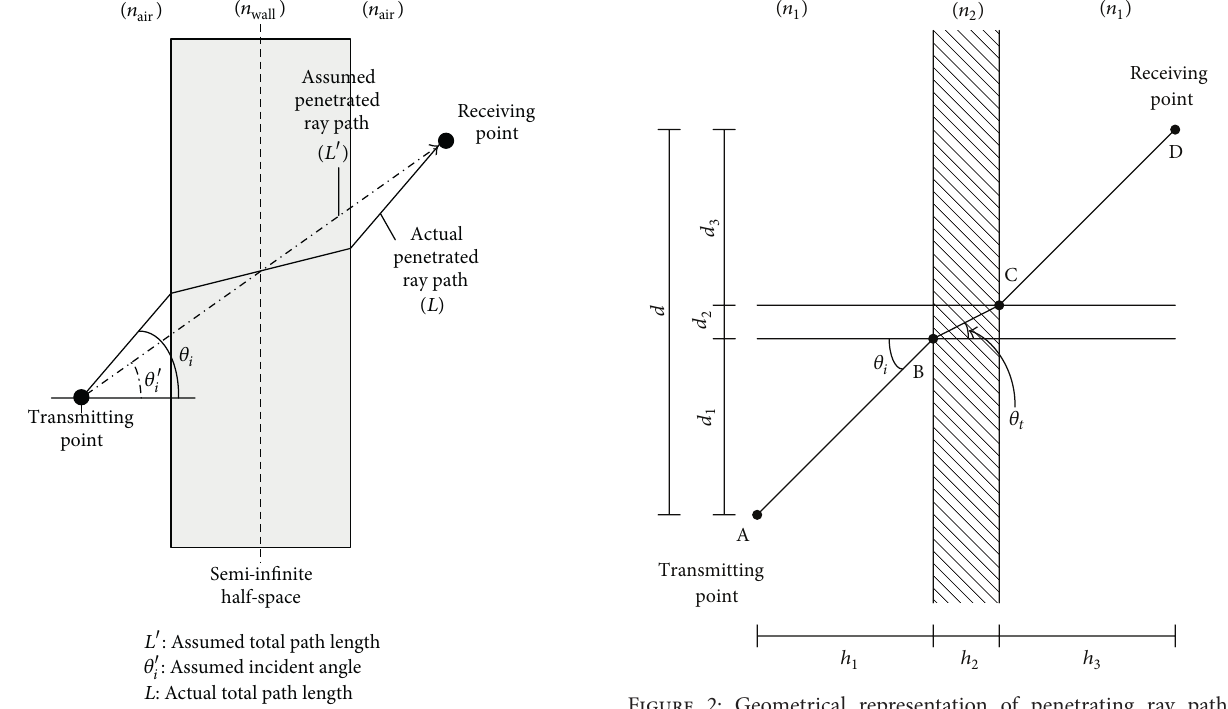
Figure 2: Geometrical representation of penetrating ray path through the